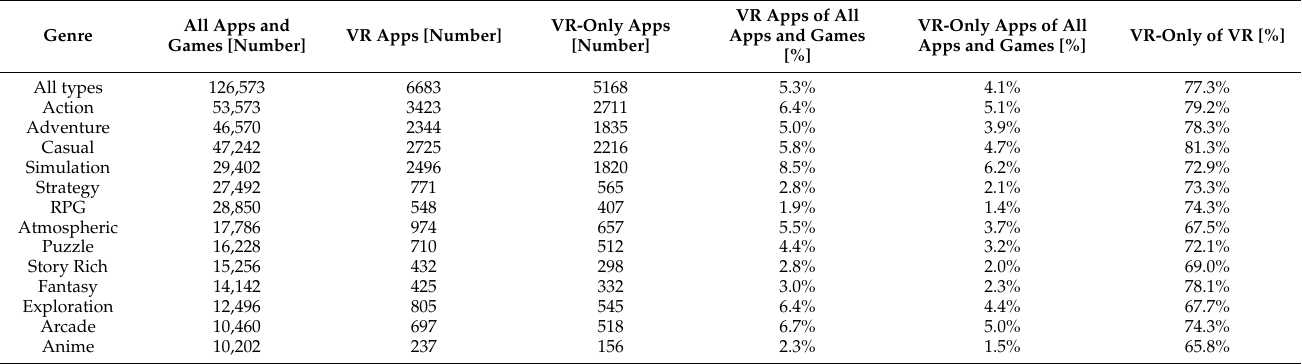
Table 1. The number and percentage of applications and games on Steam based on the genre [state on 6 July